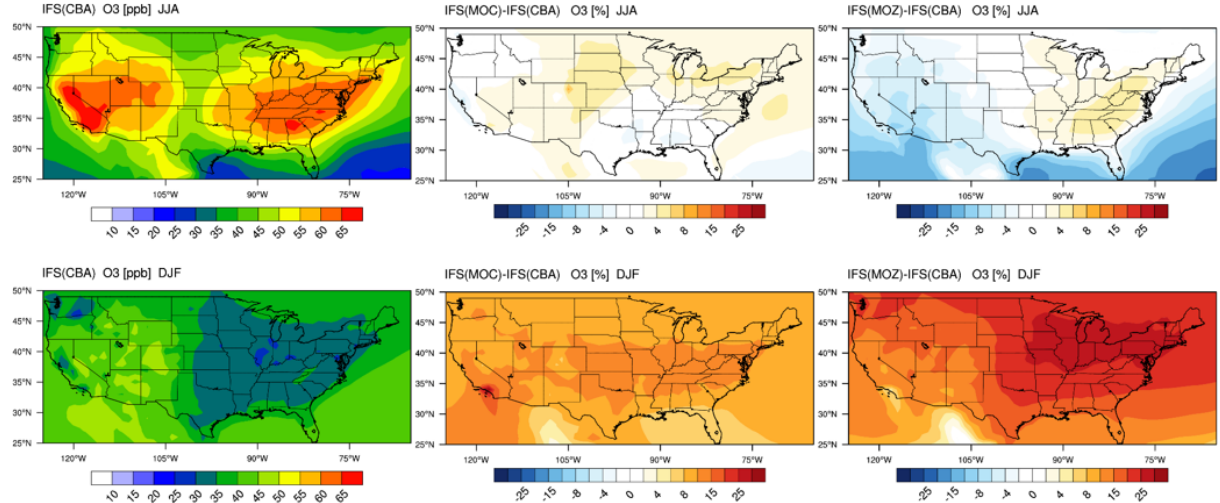
Figure 2. The horizontal seasonal mean for tropospheric O 3 below 1km over the US domain for JJA 2014 (top) and DJF 2014/2015 (bottom).